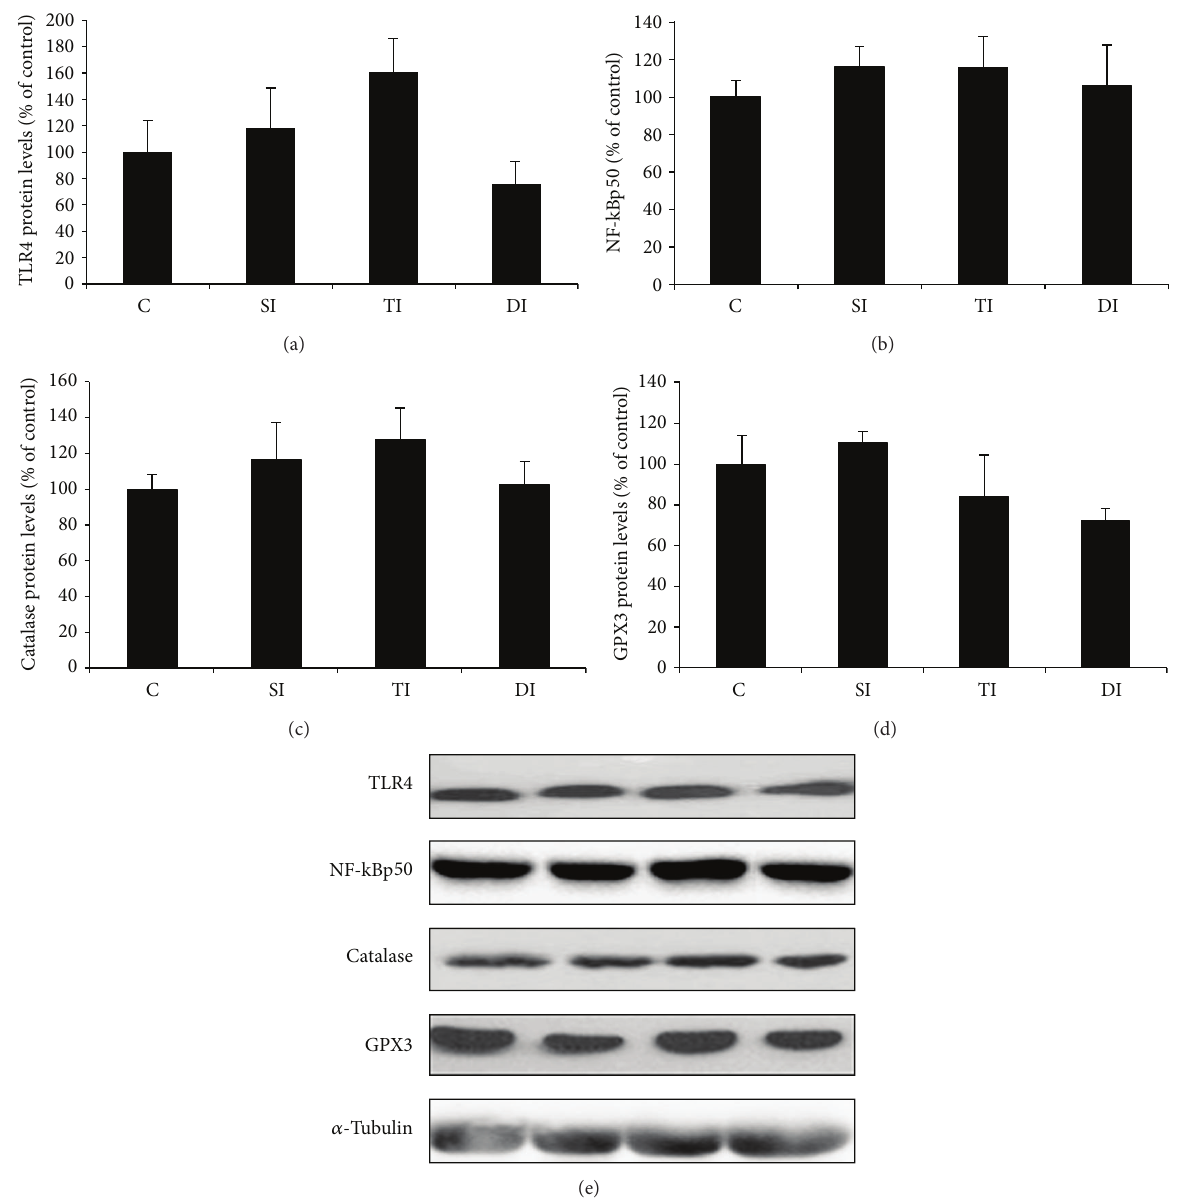
Figure 4: Protein levels of TLR4, NF-kBp50, catalase, and GPX3 on epididymal adiposetissue of control (C), sedentary infarcted (SI), trained infarcted (TI), and detrained infarcted (DI)